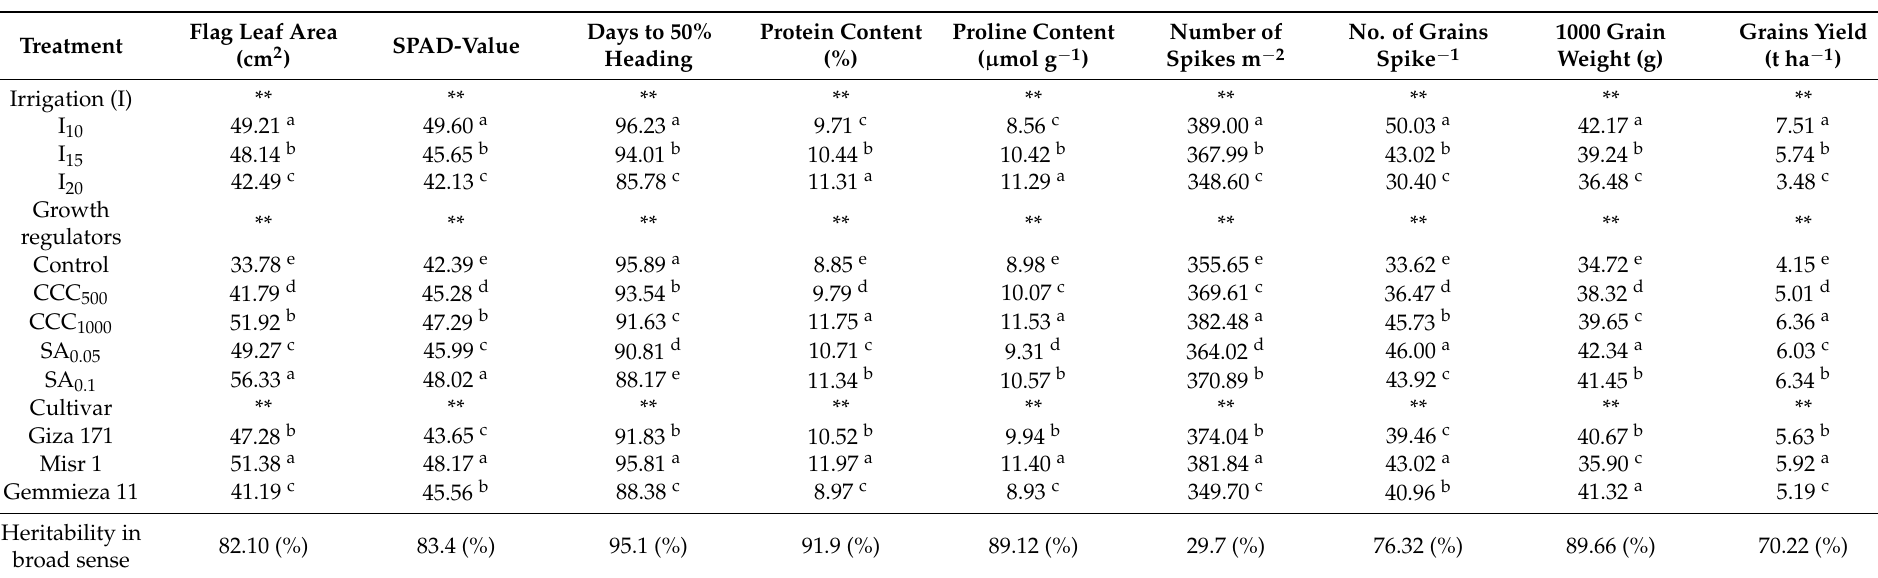
Table 3. Main effect and heritability in broad sense of irrigation intervals, growth regulators and wheat cultivars on all traits under the study of wheat (combined analysis of two seasons). Flag Leaf Area Treatment